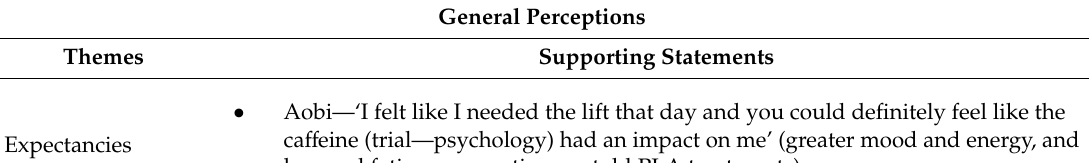
Table 5. Themes and supporting statements across areas of